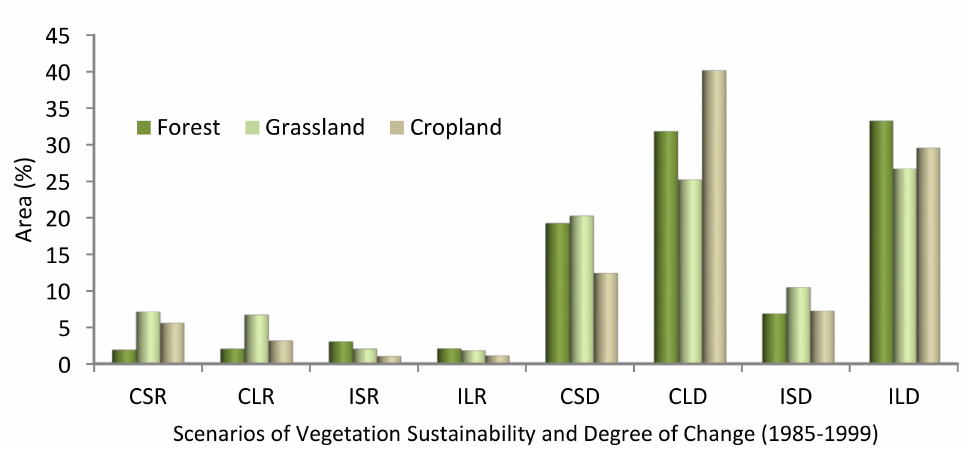
Figure 14. Sustainability and degree of NPP change under di ff erent scenarios for the base period.